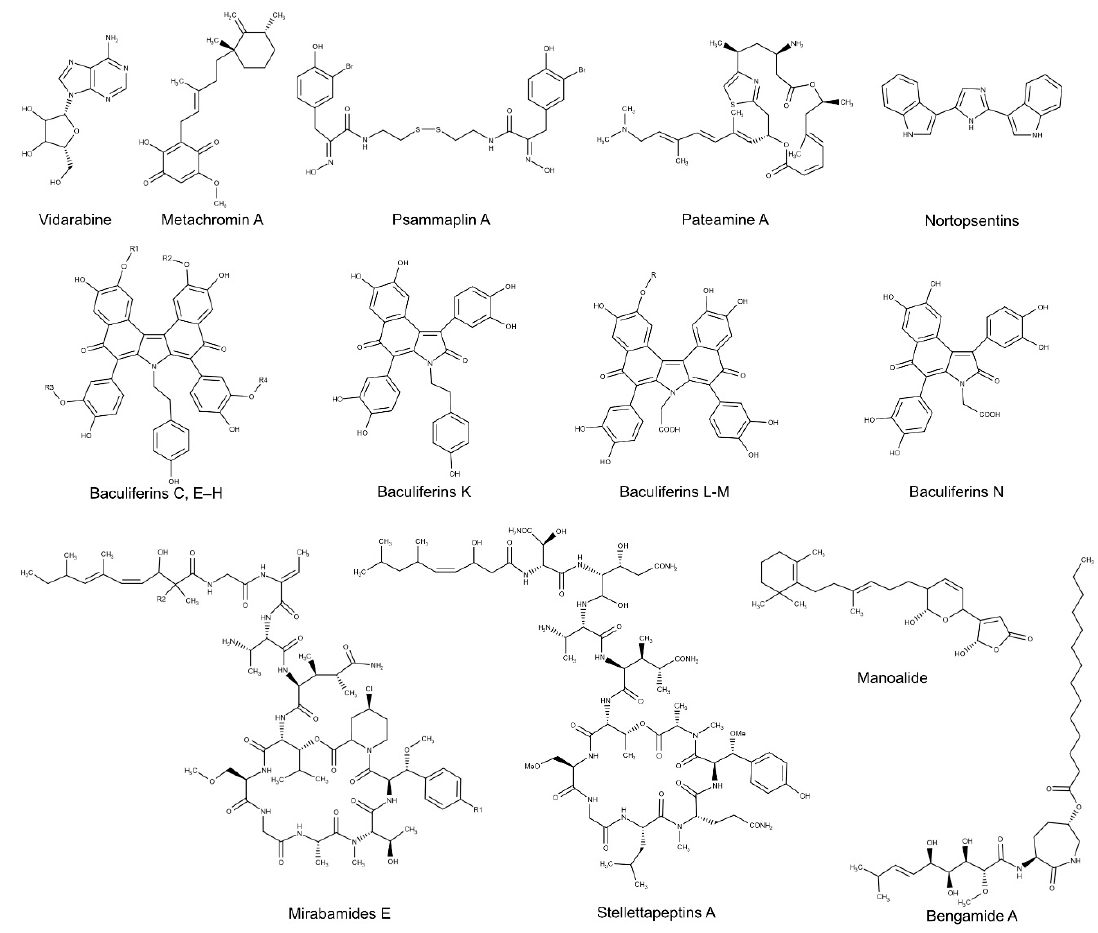
Figure 4. Compounds from sponge.